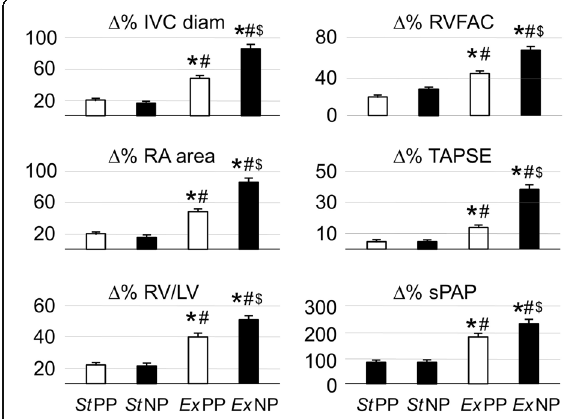
Fig. 2 Percent changes in parameters of right cardiac function after 30-min dive in each combination of pressure breathing and physical activity. StPP, static dive with positive transpulmonary pressure; StNP, static dive with negative transpulmonary pressure; ExPP, continuous finning dive with positive transpulmonary pressure; ExNP, continuous finning dive with negative transpulmonary pressure; IVC diam, diameter of inferior vena cava; RA area, right atrial area; RV/LV, ratio of right to left ventricle end-diastolic area; RVFAC, right ventricle fractional area change; TAPSE tricuspid annular plane systolic excursion; sPAP, systolic pulmonary arterial pressure. * p <0.05 significant difference between ExPP and StPP or ExNP and StNP; # p <0.05